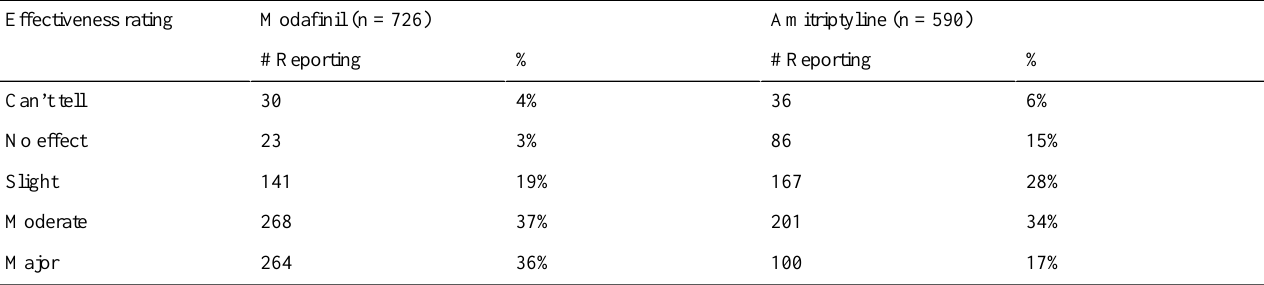
Table 2. Effectiveness ratings for modafinil and